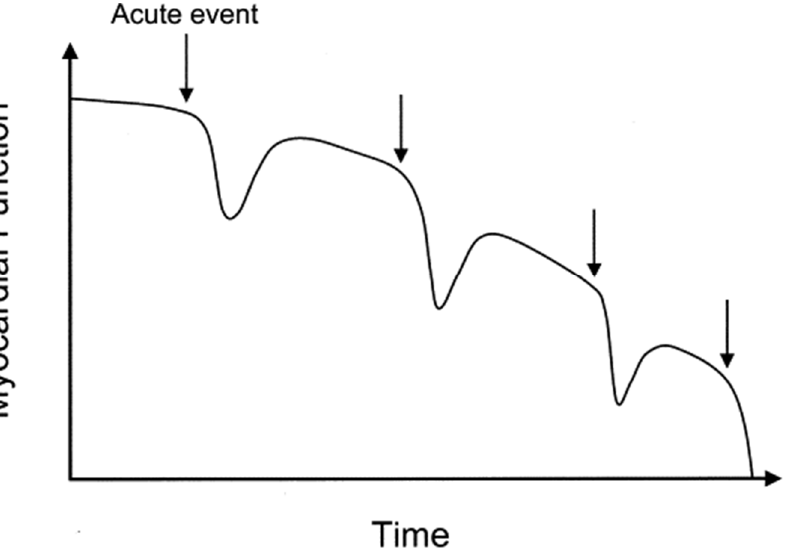
Figure 1. The effects of repeated hospital admissions for acute heart failure episodes on myocar- dial function. Reprinted from The American Journal of Cardiology, Volume 96, Issue 6, Gheorghi- ade et al., Pathophysiologic Targets in the Early Phase of Acute Heart Failure Syndromes, Pages 11–17, Copyright 2005, with permission from Elsevier [6].